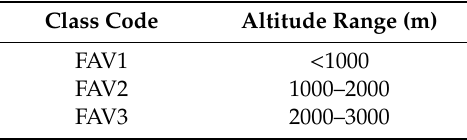
Table 3. Aosta Valley altitude ranges considered for this work to test IKC prevalence against land cover